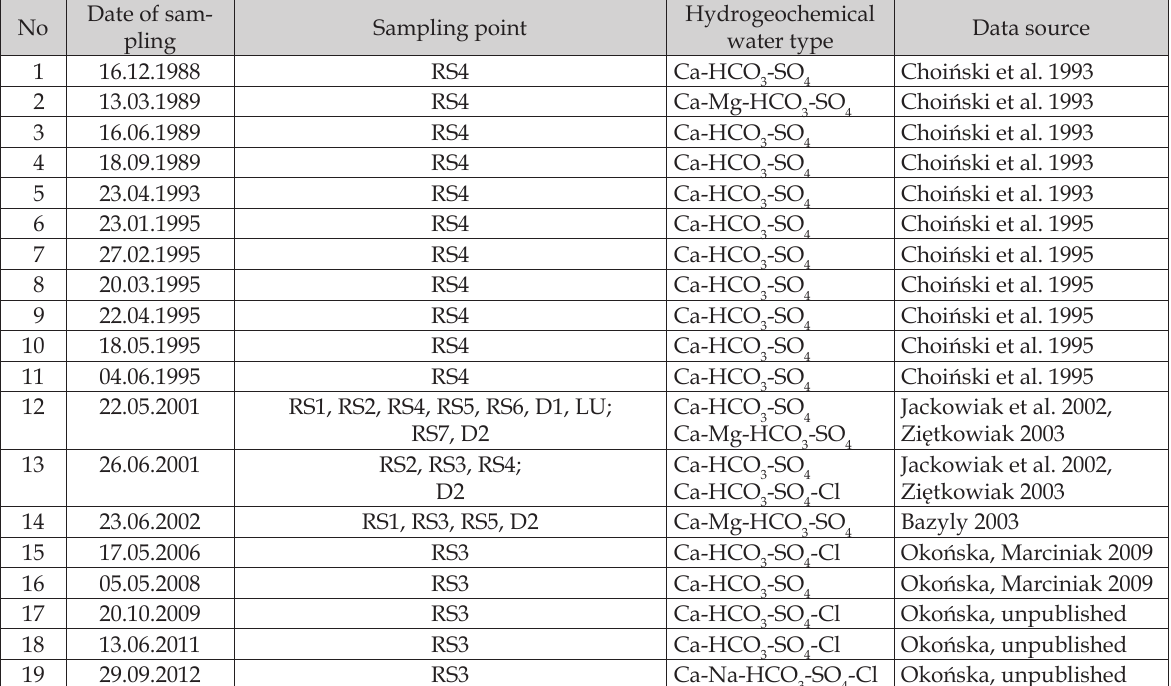
Table 1. Specification of chemistry research carried out in surface waters in the Różany Strumień catchment.